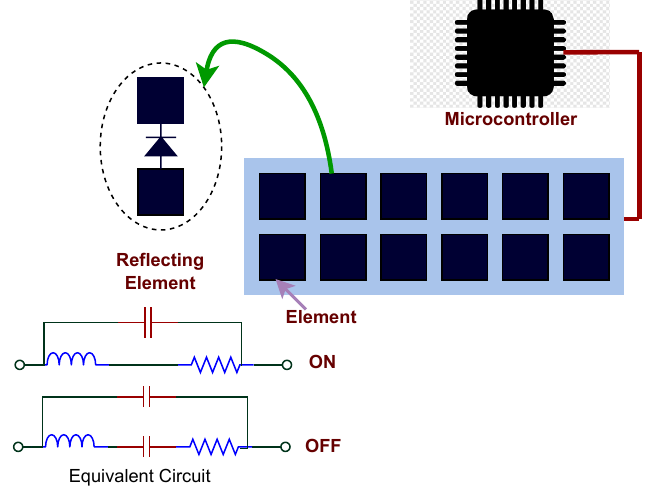
Figure 1. Basic architecture of IRS